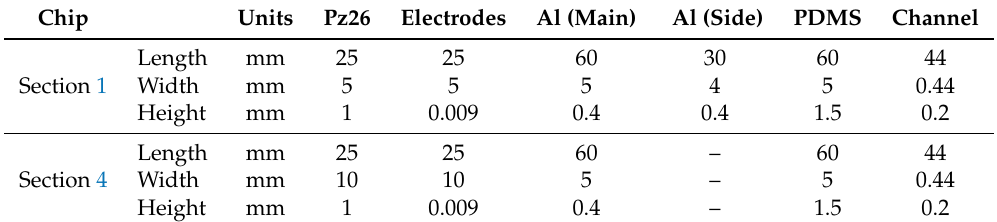
Figure 1. ( a ) 3D sketch drawn to scale of the single-PDMS-cover (beige) aluminum-based (light gray) device driven by a piezoelectric PZT-Pz26 transducer (dark gray, placed on a protrusion next to the PDMS) with silver electrodes (not shown). The inlet and outlet channels are marked by small circles. ( b ) Cross-sectional view of the device at the vertical center plane, used in the 2D model presented in Section 3, where the 9-µm-thick electrodes of the Pz26 transducer are connected to ground (purple) W fl . and to the driving ac-voltage (red). The gap between the Pz26 and the PDMS cover is 1 8 Table 1. Dimensions of the two chip geometries shown in Sections 1 and